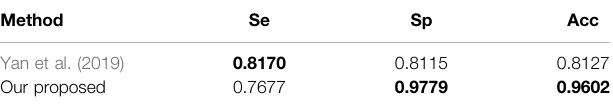
TABLE 4 | Comparison of thin vessels